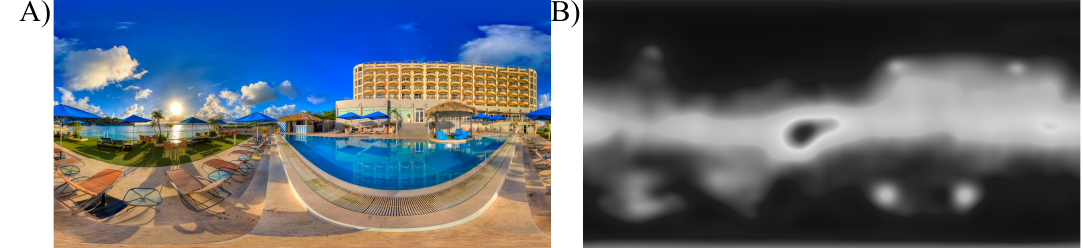
Figure 2. ( A ) Example of one omnidirectional image used in the main experiment. ( B ) The corresponding saliency map generated using the approach in [60]. White regions correspond to the most salient areas, whereas black color indicates the least salient locations.